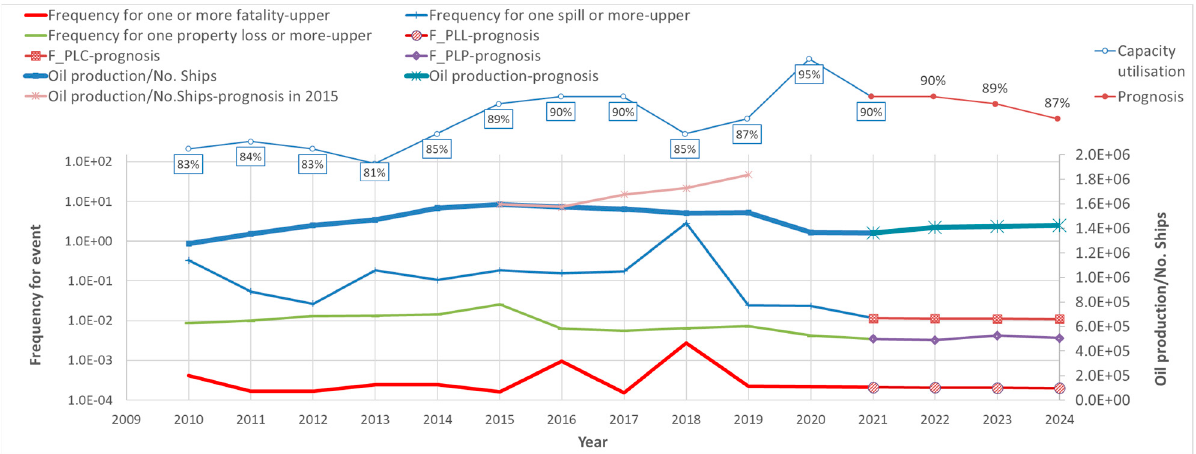
Figure 5. Events upper tolerable limit per year.